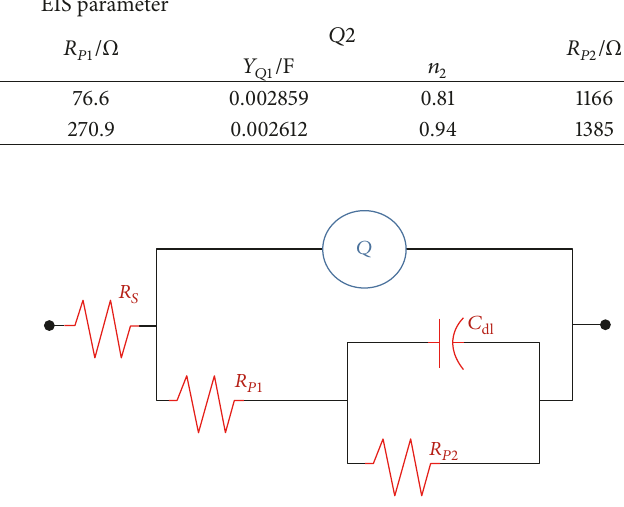
Figure 7: The equivalent circuit model used to fit EIS data shown in Figure